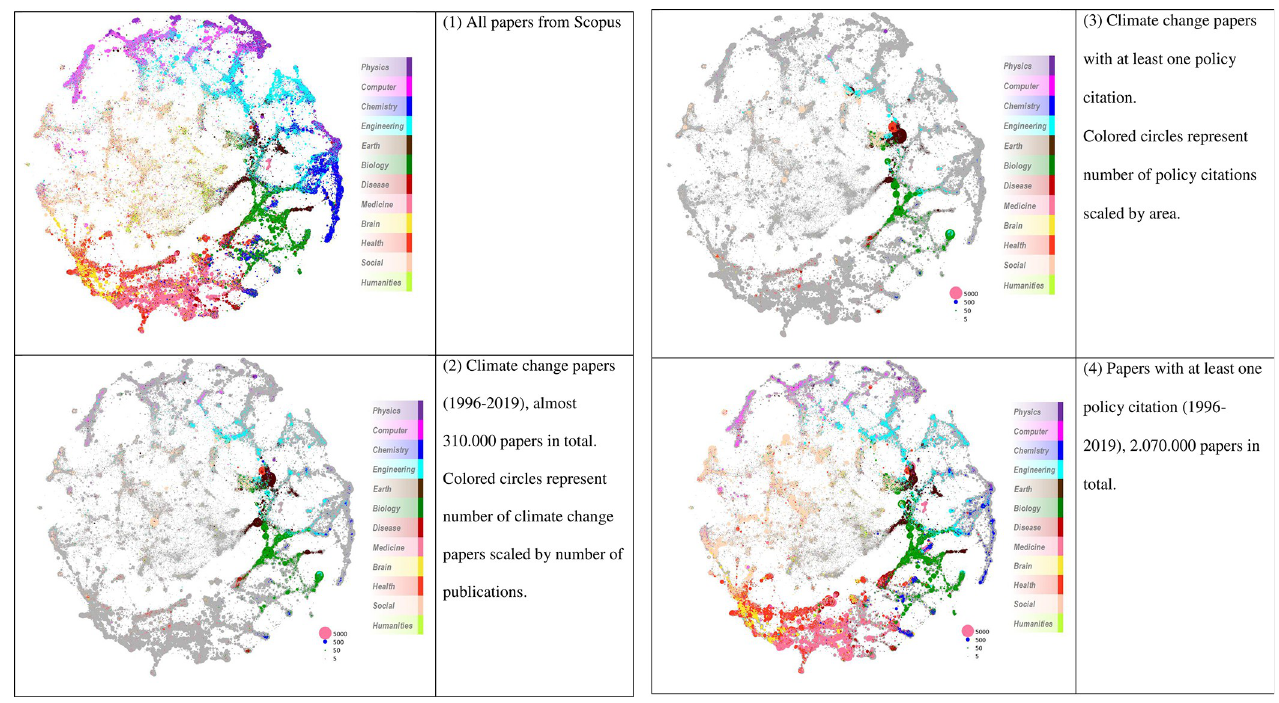
Fig 10. Overlay maps visualizing field-specific clusters of papers (based on citation relations). The maps include (1) all papers, (2) climate change papers, (3) climate change papers with at least one policy citation, (4) all papers in Scopus with at least one policy citation.